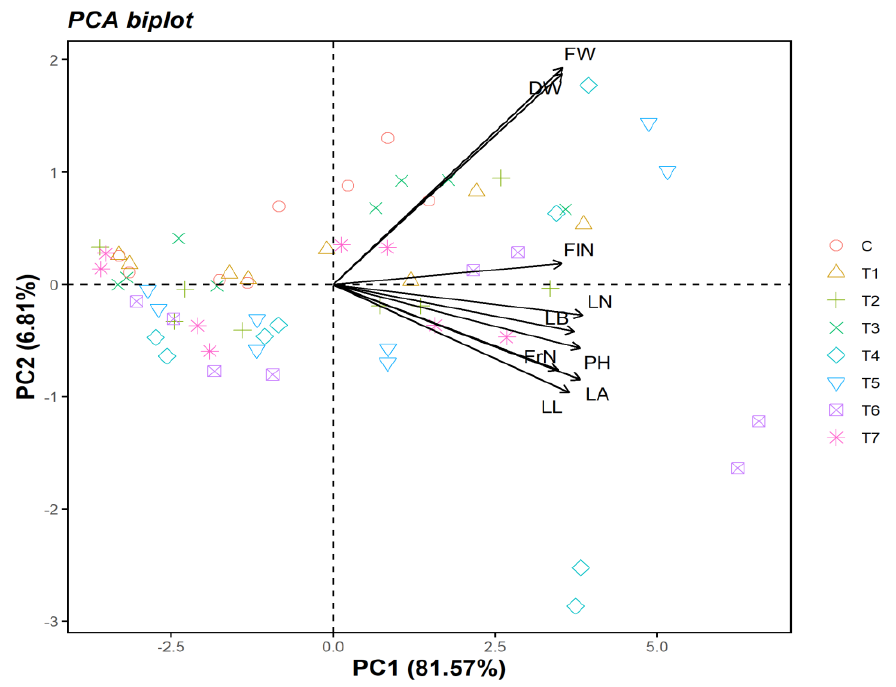
Fig. 2 PCA analysis of capsicum plant development metrics in field experiments (Plant height (cm)-PH; Leaf number-LN; Leaf length (cm)-LL; Leaf breadth (cm)-LB; Leaf area (cm) – LA; Fresh weight (g)- FW; Dry weight (g)-DW; Flower number –FlN; Fruit